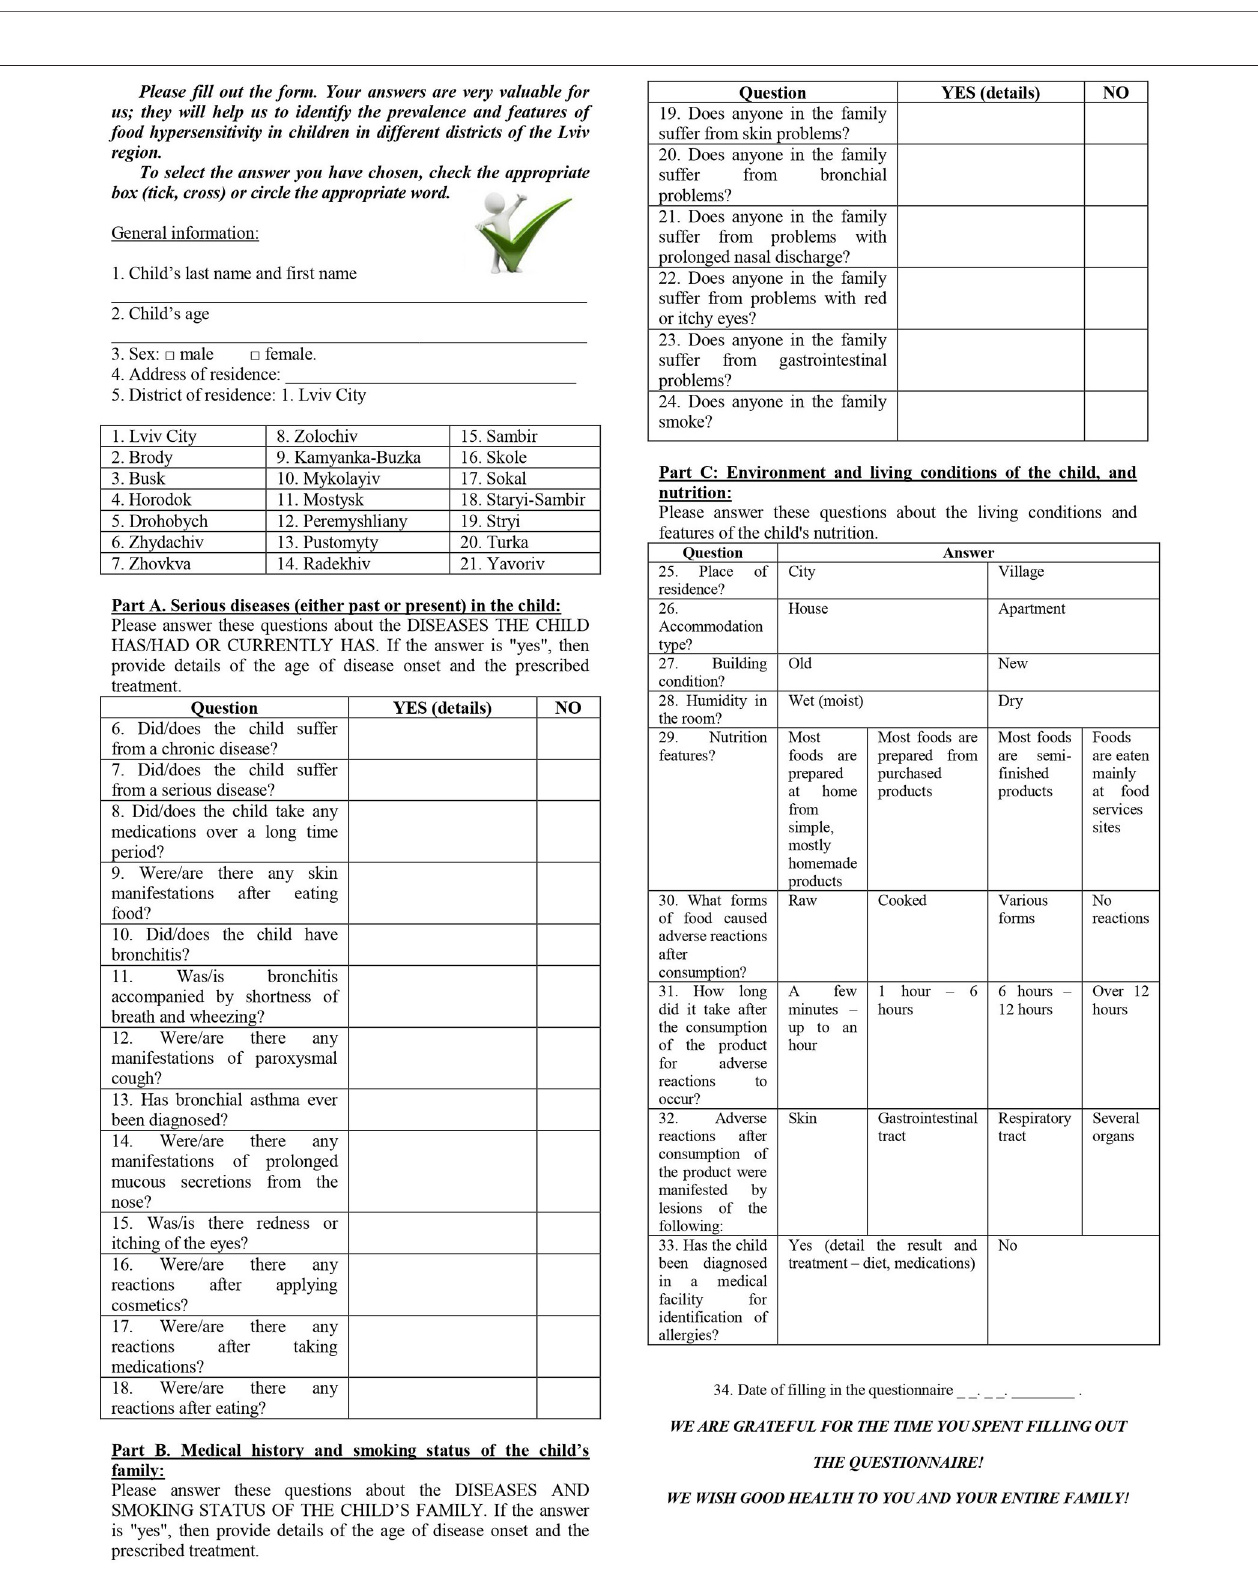
FIGURE 1 | Questionnaire used to identify children with food hypersensitivity in the Lviv region.